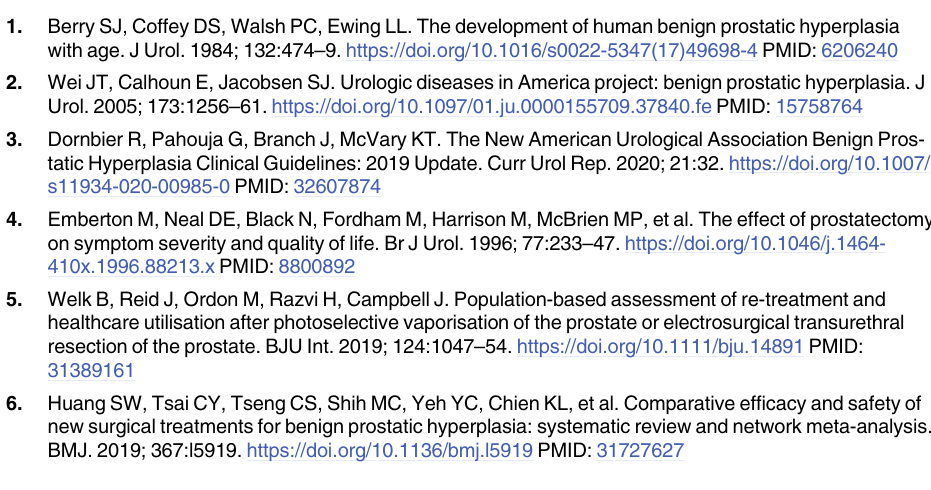
S1 Table. Age-standardized prostate surgery rates per year for 44 Hospital Service Areas. Abbreviation: HSA, Hospital Service